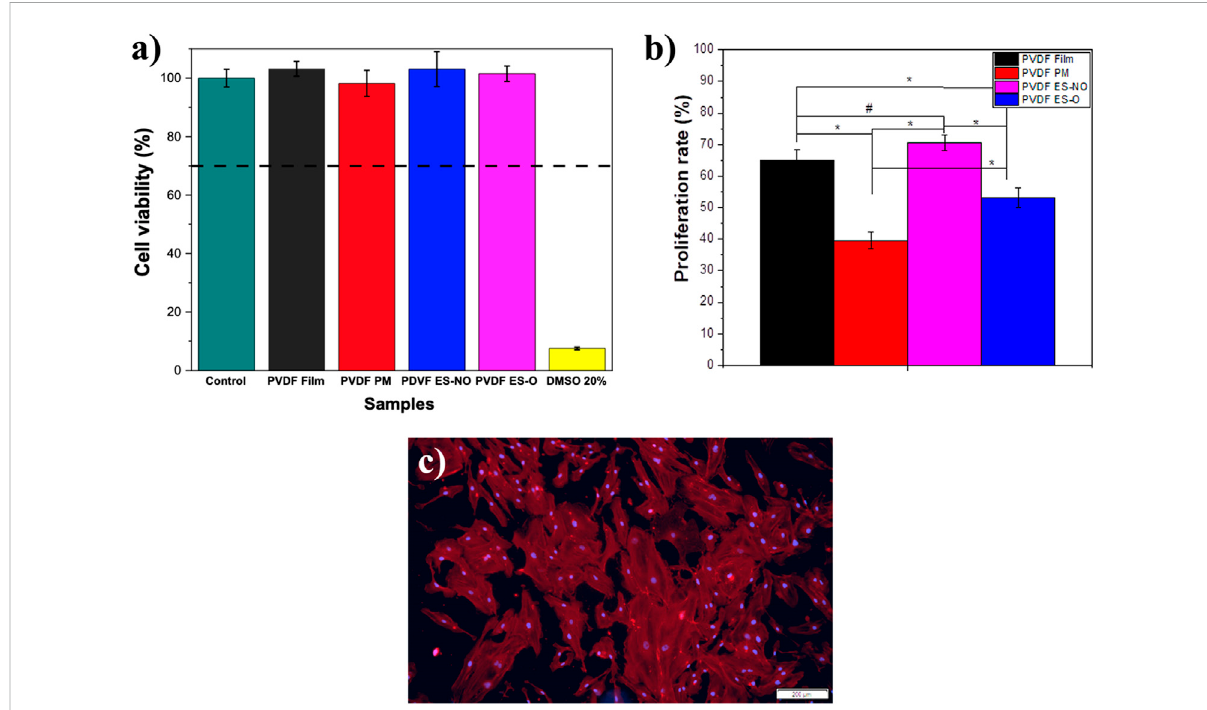
FIGURE 5 (A) Cell viability of control L929 cells, in contact with the extraction media of PVDF fi lms, porous membrane (PM), electrospun randomly- oriented membranes (ES-NO), and electrospun oriented membranes (ES-O) (relative metabolic activity was presented as the percentage of the negative control with n = 4 ± standard deviation). (B) Proliferation rate determined using the MTS assay on HUVEC ’ s cells seeded on the different PVDF samples after 4 days. The proliferation rate was calculated regarding the cells growing on the material after 24 h of cell adhesion. Results are expressed as mean ± standard deviation, n = 4. # p < 0.002 and * p < 0.0001. (C) HUVEC ’ s cells after 4 days of cell culture on PVDF fi